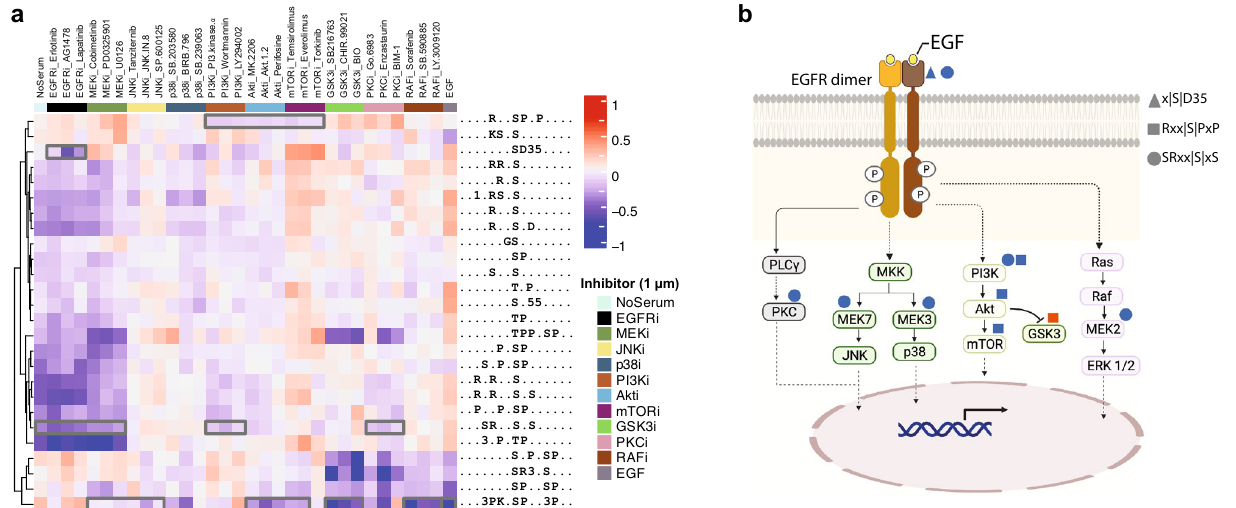
Figure 3. EGF pathway inhibition analysis. ( a ) Enriched phosphorylation patterns identified by RoLiM. Phosphosites analysed in RoLiM lacked motifs matched to curated kinases in Olsen et al. data (see “Methods”). The abundance of each pattern (calculated as the average abundance of all phosphosites, is shown for the different experimental conditions—RPE1 cells without EGF stimulation (No serum), with EGF stimulation (EGF), and treated with 1 µm of a panel of inhibitors targeting 10 kinases in the EGF pathway. ( b ) A scheme of the EGF pathway showing EGFR and downstream kinases targeted with specific inhibitors in Olsen et al. Broken lines denote a series of steps involving other proteins and phosphosite abundance changes are depicted in blue (downregulation) and red